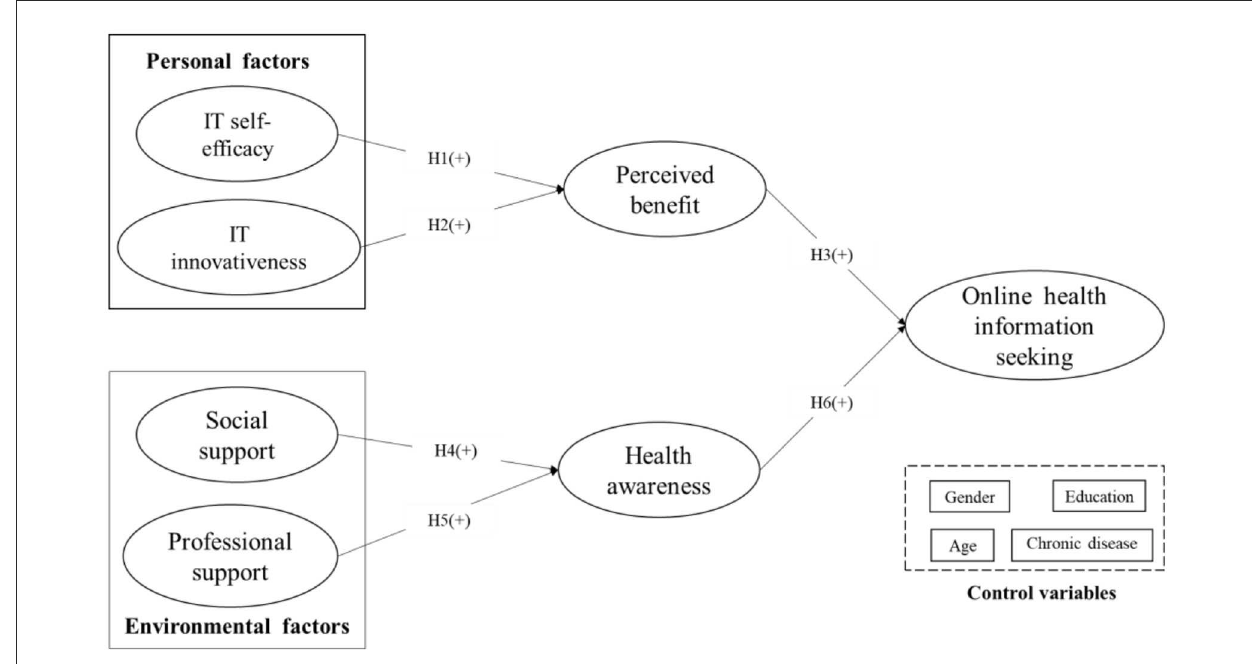
FIGURE1 Theoretical research